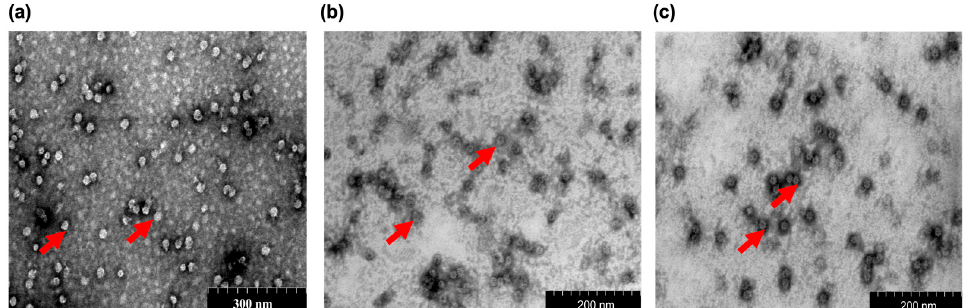
Figure 2. Scanning transmission electron microscopic (STEM) analysis of the purified recombinant proteins. Micrographs show that ( a ) protruding domain truncated-nodavirus capsid protein (C Δ 116- Mr NV-CP), ( b ) C Δ 116- Mr NV-CP fused with β -SARS-CoV-2 RBD (C Δ 116- Mr NV-CP β -RBD ), and ( c ) C Δ 116- Mr NV-CP fused with β -SARS-CoV-2 RBD (C Δ 116- Mr NV-CP δ -RBD ) assembled into spherical VLPs. Protein samples were negatively stained with 2% ( w / v ) of uranyl acetate, and viewed with 200,000× magnification as shown by the scale bar. The red arrows indicate VLPs formed.